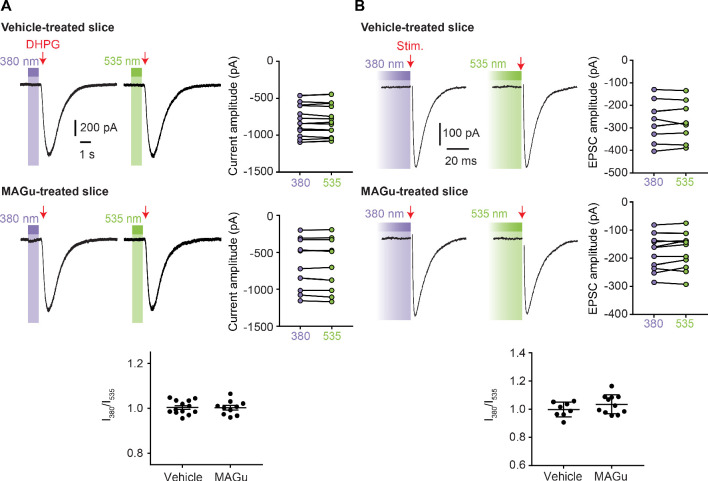
MAGu does not photosensitize native GluD and GluA currents in Purkinje cells.(A) Top, DHPG (200 μM)-induced current in vehicle-treated cerebellar slices were of similar amplitude under 380 and 535 nm light (−800 ± 57 pA vs. −799 ± 57 pA, p>0.999, n = 10). Middle, DHPG (200 μM)-induced current in MAGu-treated cerebellar slices were of similar amplitude under 380 and 535 nm light (−666 ± 113 pA vs. −661 ± 111 pA, p=0.625, n = 13). Bottom, ratio between the current measured under 380 and 535 nm light are not different from one for both vehicle-treated (1.004 ± 0.008, p=0.6475) and MAGu-treated cells (1.003 ± 0.01, p=0.7755). (B) Top, Excitatory post-synaptic currents (EPSCs) in vehicle-treated cerebellar slices were of similar amplitude under 380 and 535 nm light (−272 ± 32 pA vs −273 ± 34 pA, p=0.742, n = 8). Middle, EPSCs in MAGu-treated cerebellar slices were of similar amplitude under 380 and 535 nm light (−176 ± 20 pA vs. −180 ± 19 pA, p=0.320, n = 11). Bottom, ratio between the current measured under 380 and 535 nm light are not different from one for both vehicle-treated (0.9976 ± 0.0185, p>0.999) and MAGu-treated cells (1.035 ± 0.020, p=0.1748). Data are presented as mean value ± sem.